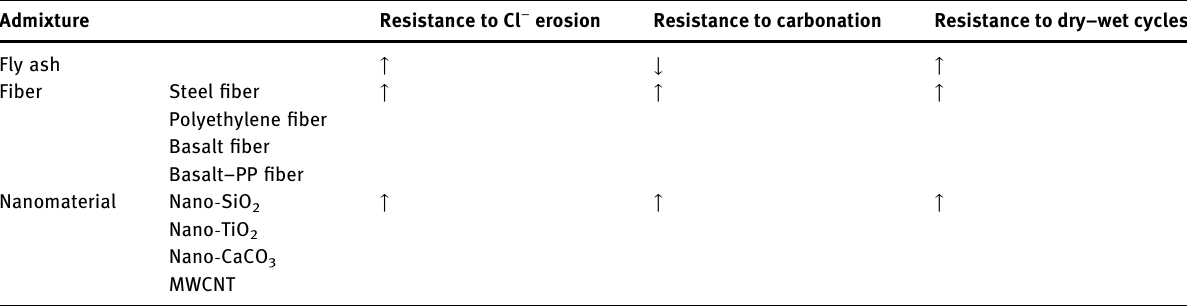
Table 3: In fl uence of admixture types on concrete properties